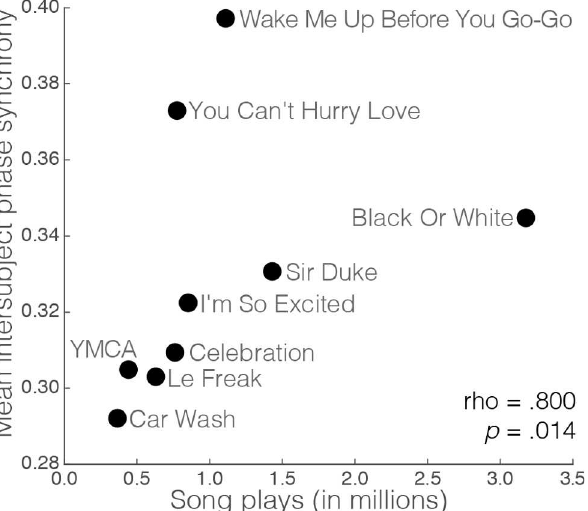
Fig 2. Relationship between group synchrony of movement and song popularity. Play counts from music websites and applications for each song are plotted against their average intersubject phase synchronization